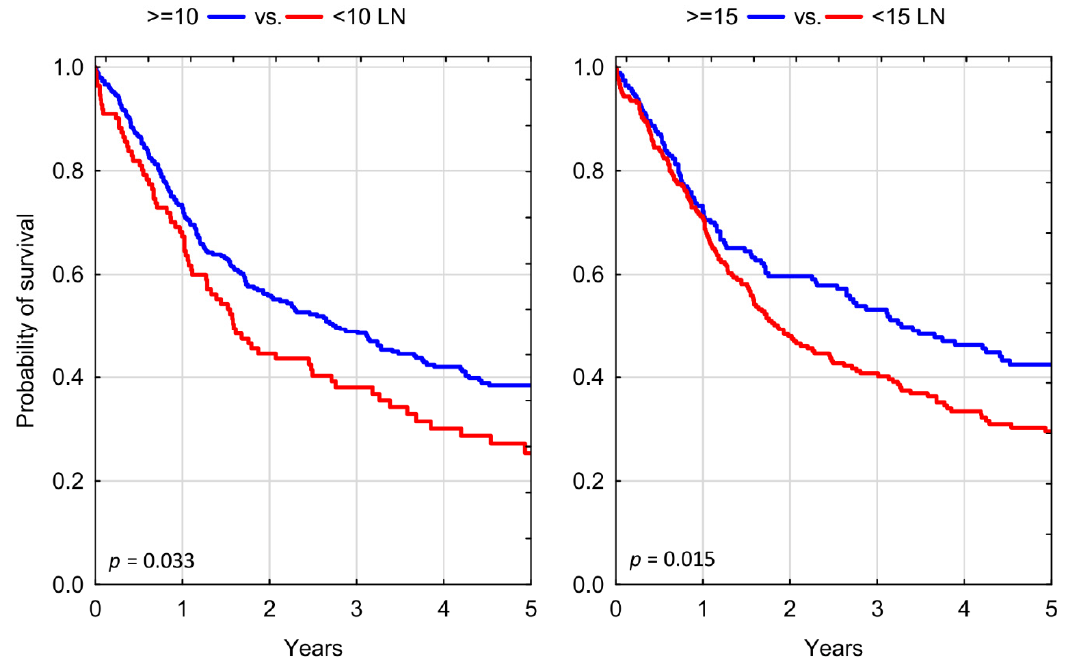
Figure 2. Kaplan–Meier analysis of overall survival in patients who underwent radical cystectomy stratified according to different thresholds of adequate lymph node dissection; LN: lymph nodes.